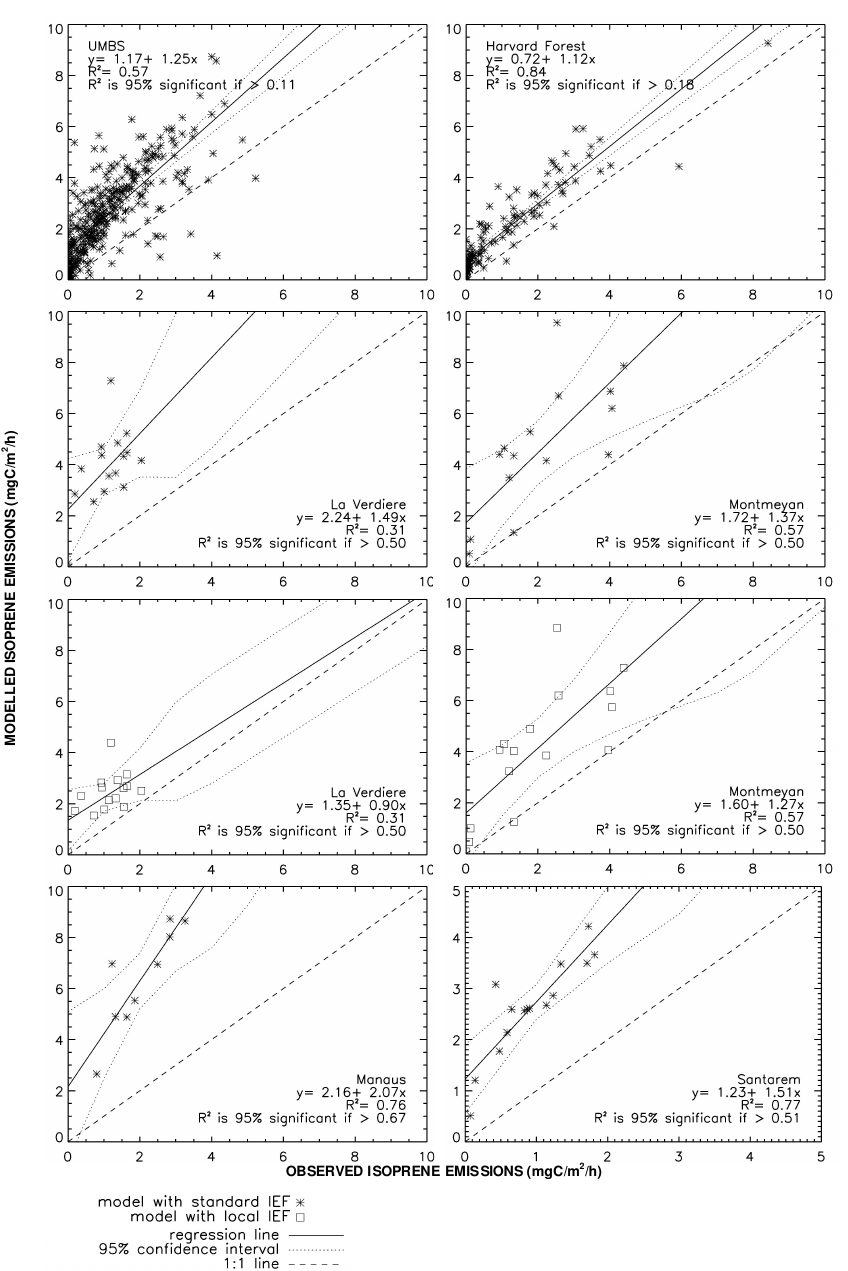
Fig. 3. Scatter plots of simulated and ground-based measured daily average isoprene emissions at the flux tower sites listed in Table 1, including regression line, 95% confidence interval (Scheffe’s method) and 1:1 line. Isoprene emissions were simulated using standard isoprene emission factors (IEFs) from Guenther et al. (1995) and local IEFs when available (second row of